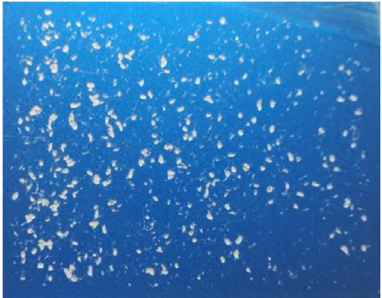
Figure 12. The morphology of coating failure.